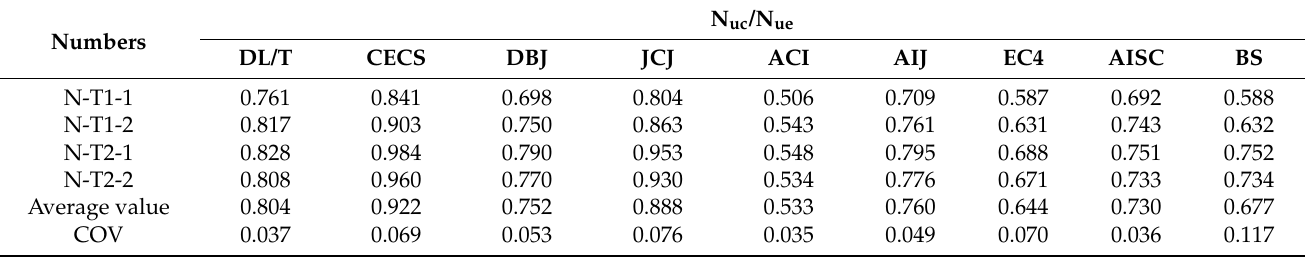
Table 4. Comparison of the ultimate loads between calculated values and experimental